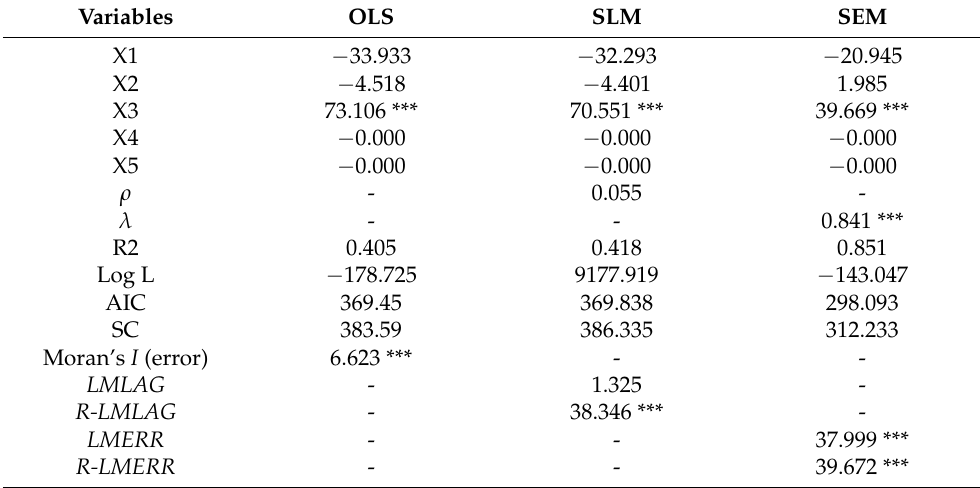
Table 2. Estimation results of the effect of urban green space fractal indicators on urban ther- mal